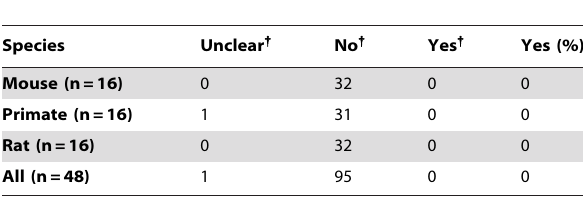
Table 10. Number of studies that explained the sample size.